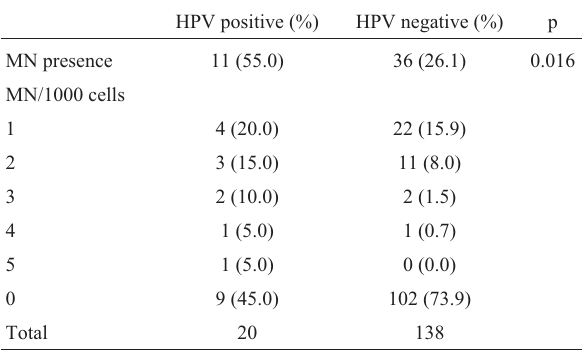
Table 1 - Association between micronucleus presence/frequency and HPV-DNA in cytologically normal